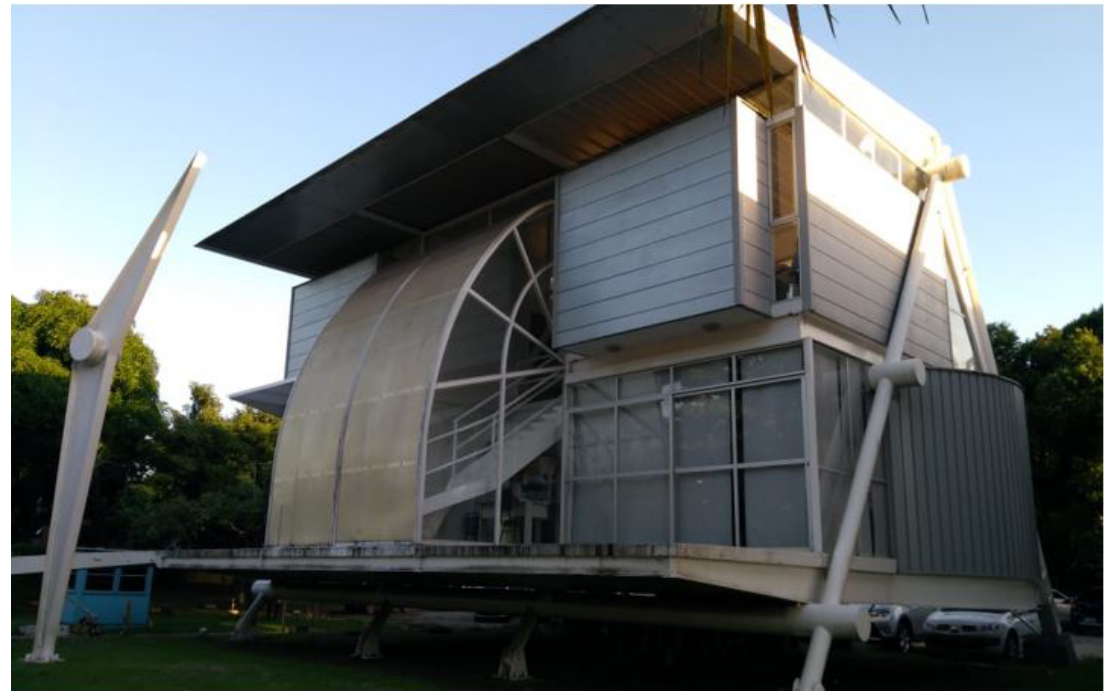
Figure 7. Nexem (Breda et al.